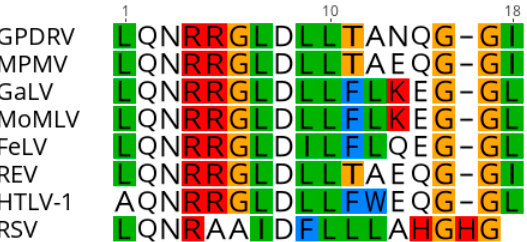
Figure 6. Alignment of the immunosuppressive domain from retroviral transmembrane protein sequences. Amino acid alignment was constructed using sequences GPDRV- Gunnison’s prairie dog retrovirus (this manuscript), MPMV- Mason-Pfizer monkey virus (NC_001550), GaLV- Gibbon ape leukemia virus (NC_001885), MoMLV-Moloney murine leukemia virus (NC_001501), FeLV- feline